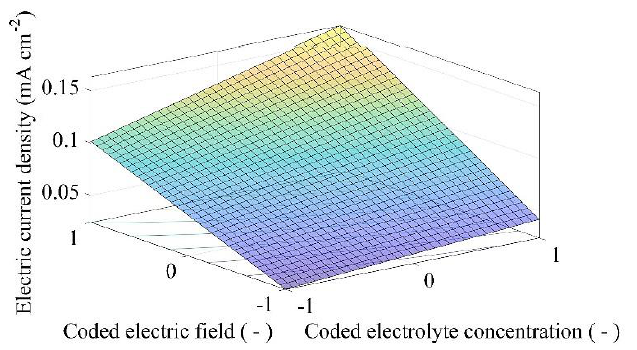
Figure 5. Electric current density function considering the coded design variables.